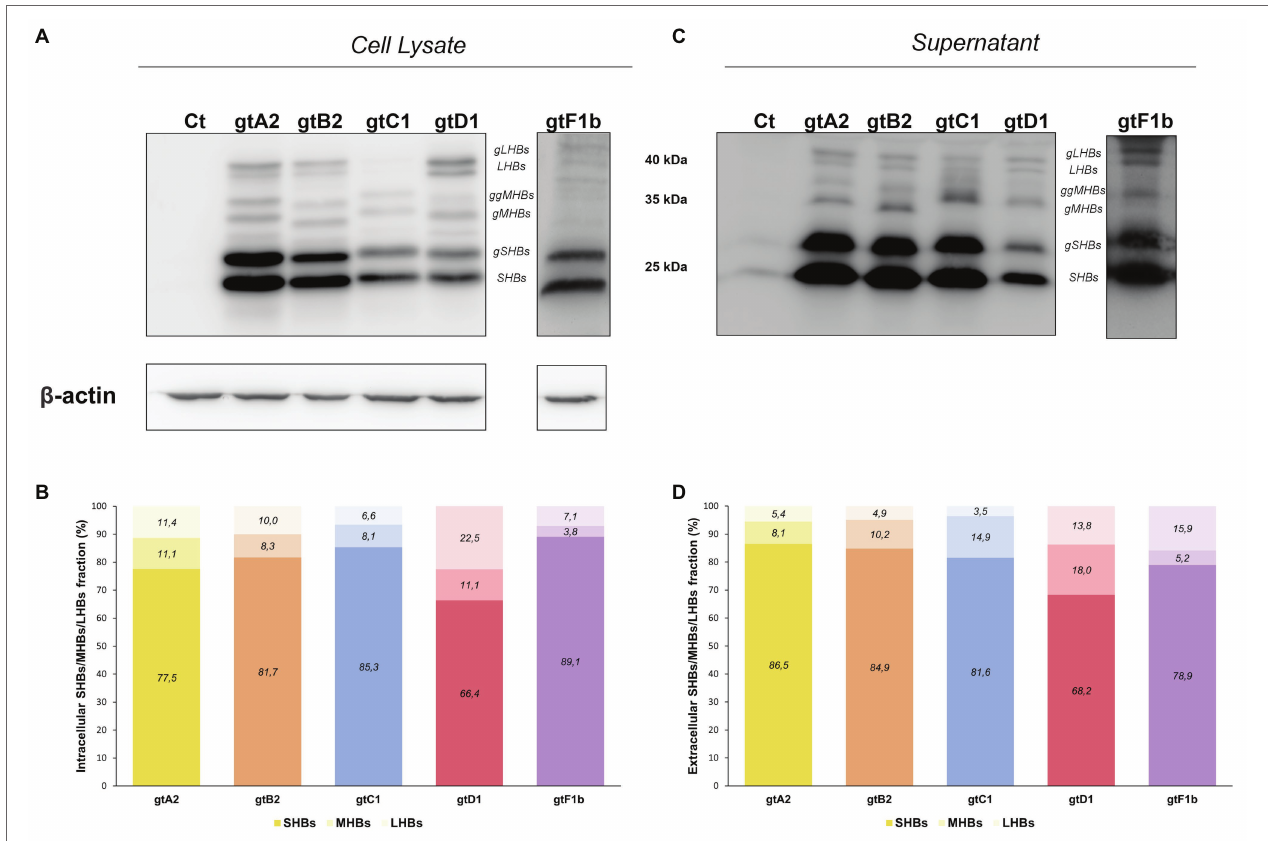
FIGURE 5 | Relative composition of HBsAg proteins among genotypes. HuH-7 cells were transfected with linear full-length HBV genomes of genotypes A2, B2, C1, D1, and F1b. Three days post-transfection, cellular lysates (A) and the corresponding culture supernatants (B) were analyzed by Western Blot, using a SHBs specific monoclonal (HB01) antibody. As this antibody shows a decreased reactivity for HBsAg derived from genotype F transfected cells, an increased time of exposure was needed. SHBs and LHBs occur in unglycosylated (LHBs and SHBs) and glycosylated (gLHBs and gSHBs) forms, while MHBs occurs in glycosylated